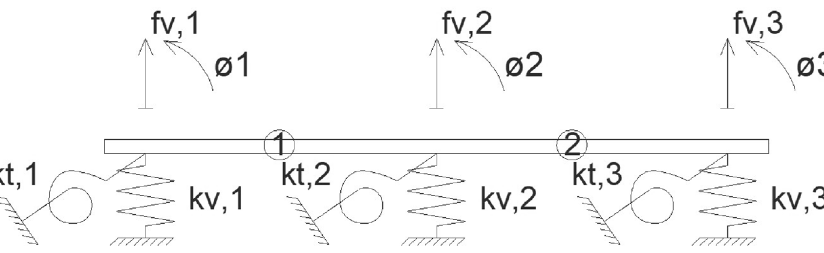
Figure 2. Proposed method model for cross-sectional distribution on a girder bridge